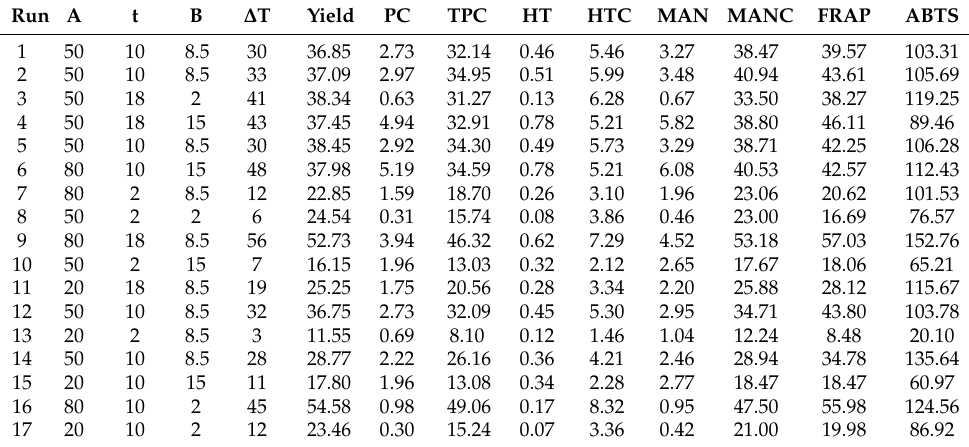
Table 2. Box–Behnken experimental design applied to the ultrasound-assisted water extraction of exhausted olive pomace (EOP) and experimental values for: yield (%), phenolic concentration (PC) (g gallic acid equivalents/L), total phenolic content (TPC) (mg gallic acid equivalents/g dry EOP), hydroxytyrosol concentration (HT) (g/L), hydroxytytrosol content (HTC) (mg/g dry EOP), mannitol concentration (MAN) (g/L), mannitol content (MANC) (mg/g dry EOP) and antioxidant activity (FRAP and ABTS) (mg Trolox equivalents/g dry EOP). Run A